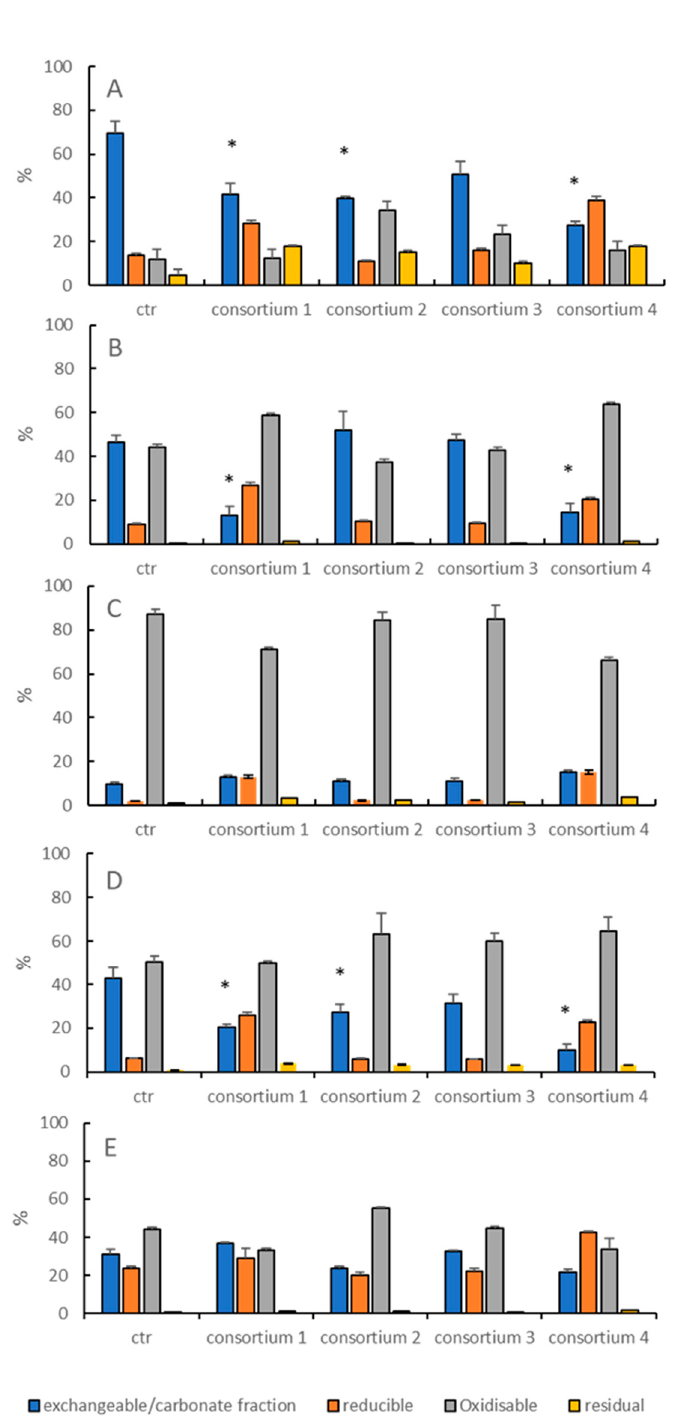
Figure 5. Heavy metal distribution in the four fractions (exchangeable / carbonate, oxidisable, reducible, and residual fractions) after 27 days of incubation of polluted sediments in the presence of the four mixed cultures (see Table 1 for bacterial composition) and in the control microcosm (ctr). Panel ( A ), arsenic; ( B ), cadmium; ( C ), copper; ( D ), lead; ( E ), zinc. The asterisk (*) indicates significant difference between treatments and control.